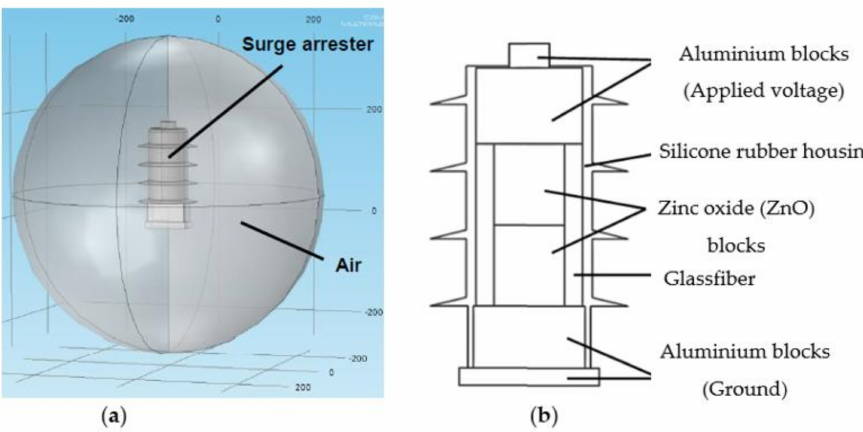
Figure 2. Surge arrester model; ( a ) drawn in 3D; ( b ) detailed structure of the model.